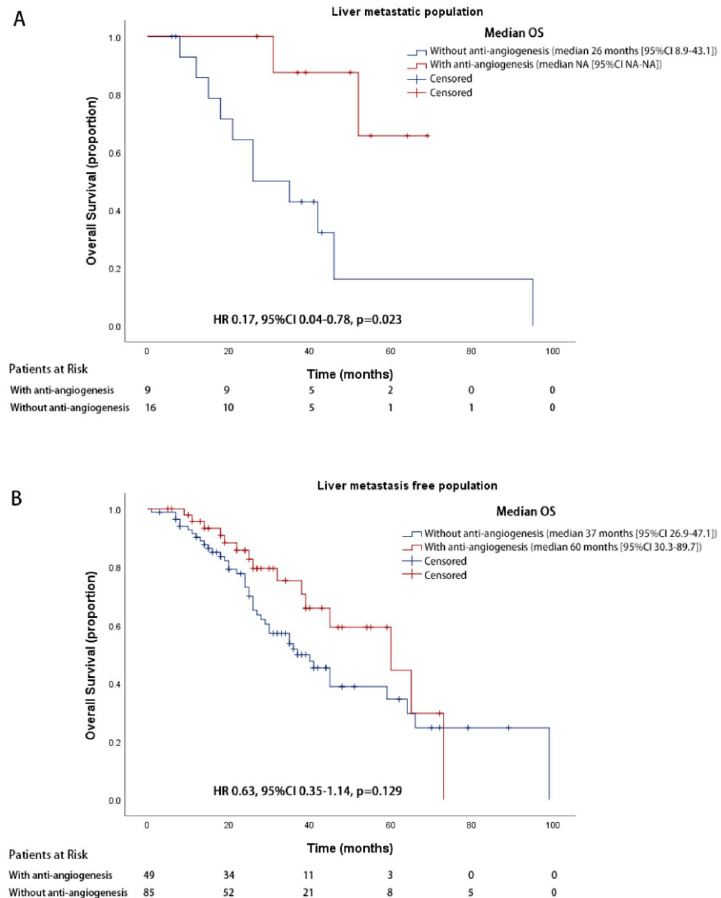
Figure 3. Kaplan–Meier survival curve of overall survival for liver metastatic patients ( A ) or liver metastasis- free patients ( B ) treated with or without anti-angiogenesis